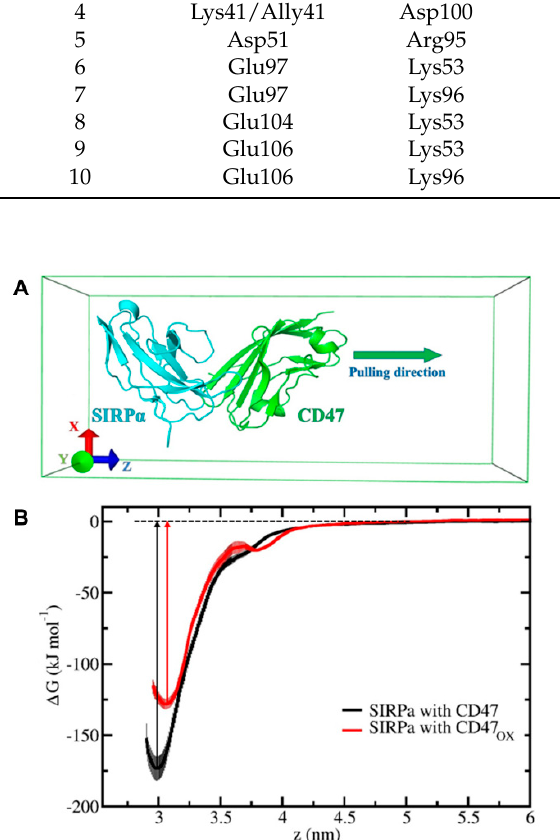
Figure 5. In silico evaluation to determine the effect of CD47 oxidation on binding affinity with SIRP α . ( A ) CD47 and CD47 OX were pulled against SIRP α . ( B ) Free energy profiles (FEPs) of the native (black) and oxidized (red) CD47 structures dissociated from SIRP α , indicate the dissociation energy. Errors associated with the sampling are presented in pale color.